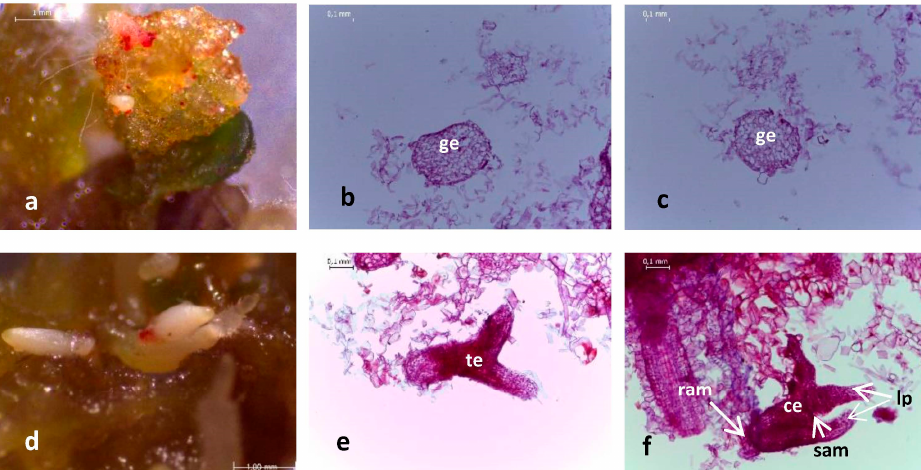
Figure 2. Histological images of embryogenic callus derived from the hairy root line LRT 6.4 of L. racemosa. ( a ) embryogenic callus at 5 dpp on MS/B5 medium with 1.0% sucrose; ( b , c ) somatic embryos at globular stage (ge); ( d ) embryogenic callus at 15 dpp on MS/B5 medium with 3.0% sucrose; ( e ) somatic embryo at torpedo stage (te); ( f ) somatic embryo at cotyledon stage (ce) showing both, shoot apical meristem (sam) and root apical meristem (ram), leaf primordia (lp) are present as well. ( a ) (35×) and ( d ) (20×) scale bar 1.0 mm, ( b , c ) and ( e , f ) (10×) scale bar 0.1 mm.